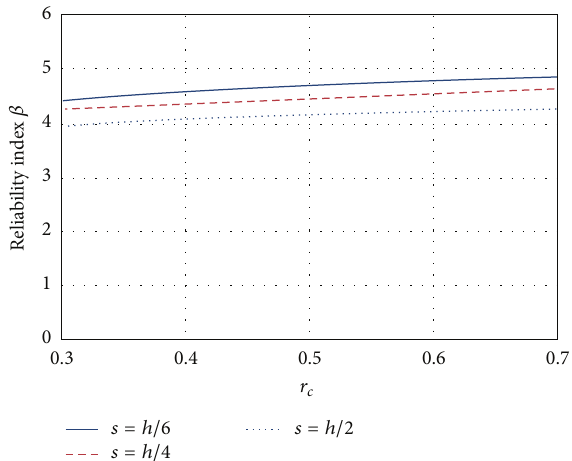
Figure 6: Influence on the structural reliability of the transversal reinforcement.